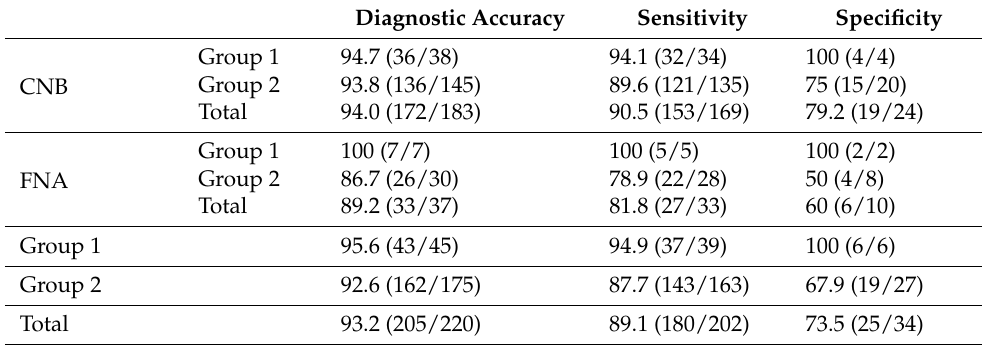
Table 2. Subgroup analysis for CNB and FNA.